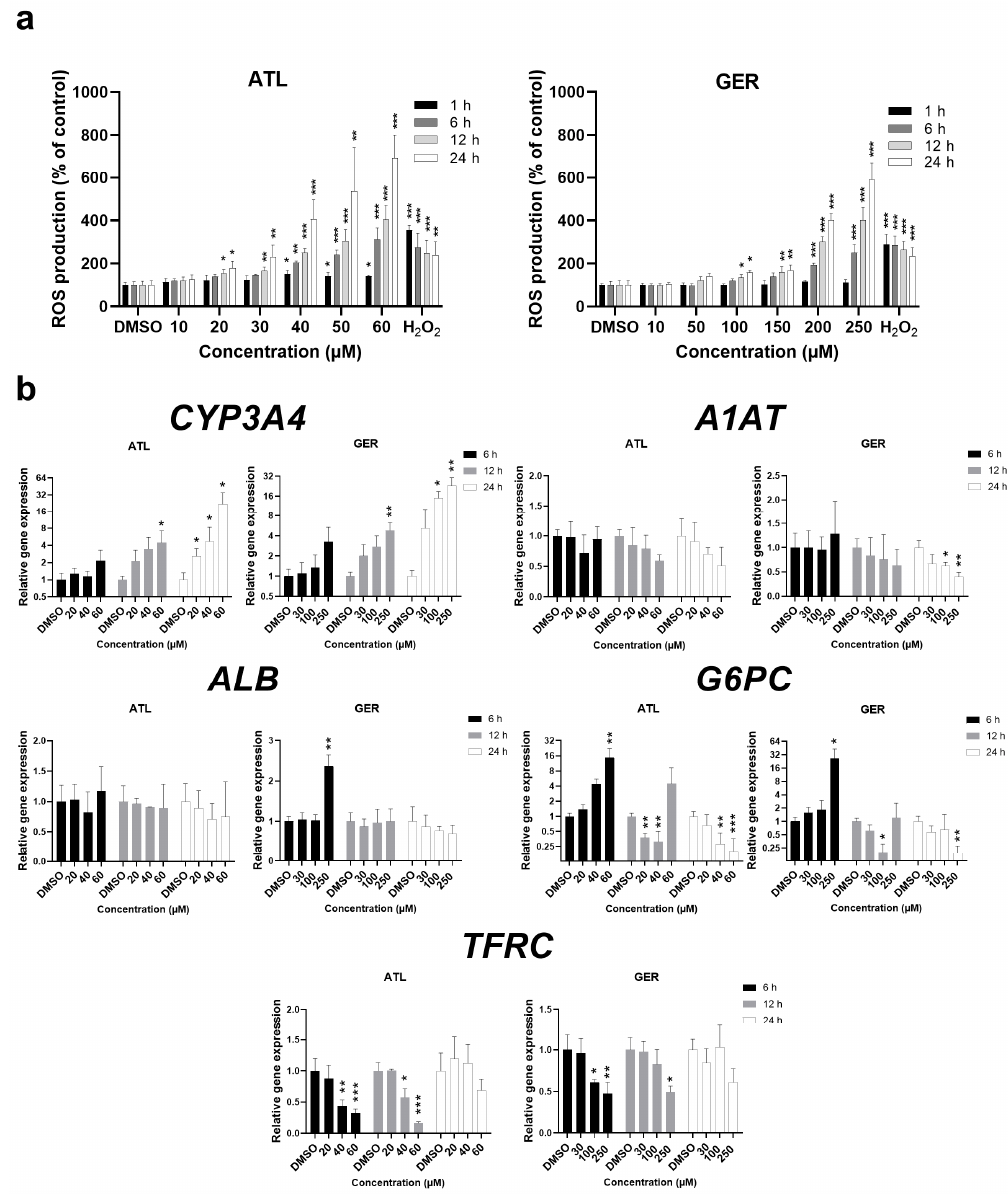
Figure 1. ( a ) Intracellular formation of reactive oxygen species in ATL and GER treated dHepaRG cells, measured using the H 2 -DCFDA (2',7'-dichlorodihydrofluorescein diacetate) probe in comparison to a positive control of 300 µM H 2 O 2 ; ( b ) mRNA expression changes on markers of mature hepatocytes: cytochrome P450 3A4 ( CYP3A4 ), alpha-1-antytrypsin ( A1AT ), albumin ( ALB ), glucose-6-phosphatase ( G6PC ), and transferrin receptor ( TFRC ). DMSO, dimethylsulfoxide. Results are expressed as the mean ± SD from three independent experiments. Results statistically significant: p < 0.05 (*), p < 0.01 (**), p < 0.001 (***).